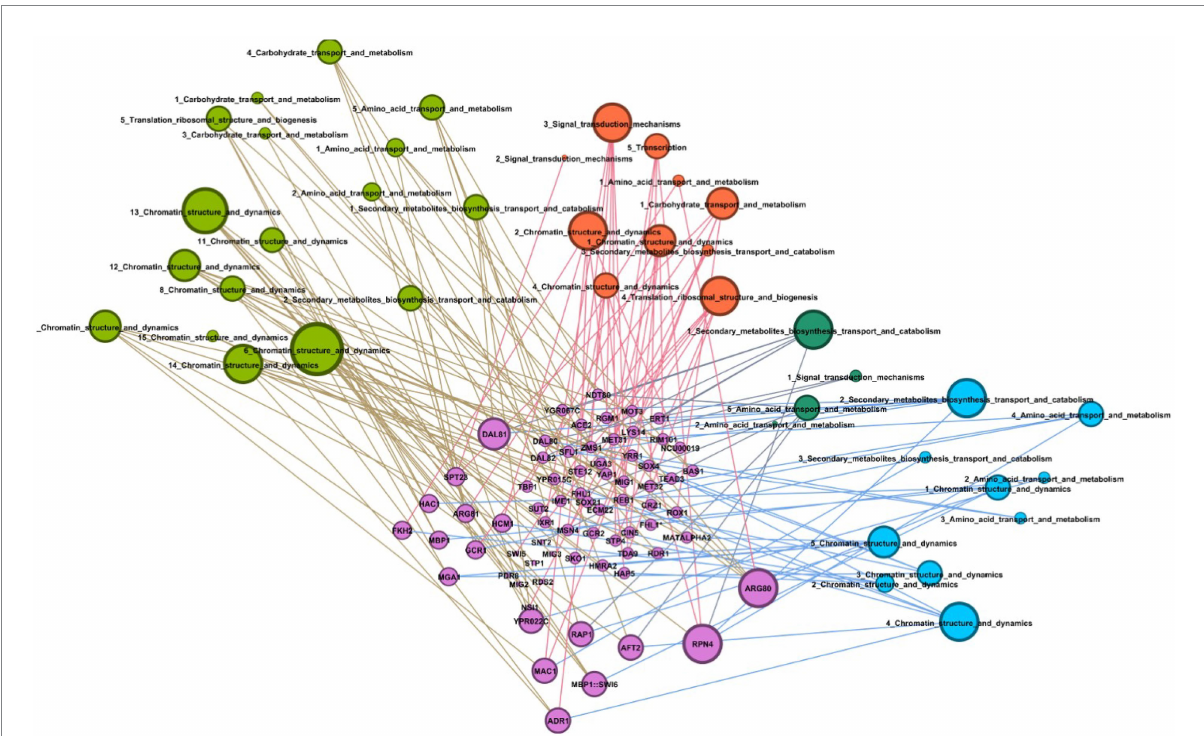
FIGURE 7 Graph of putative transcription factors and their putative binding sites. Graph showing interaction between putative transcription factors for R. toruloides with the transcription factors (TF) binding motifs predicted using HOMER. Green nodes represent the sugarcane juice condition, orange nodes represent the 42 ° C condition, dark green nodes are the 2% ethanol, and blue nodes are the 4% ethanol condition. Written inside nodes are the number of the TFBS and the name of the gene class annotated by eukaryotic orthologous groups (KOG) in which that motif was found. Pink nodes are the putative transcription FTs found using